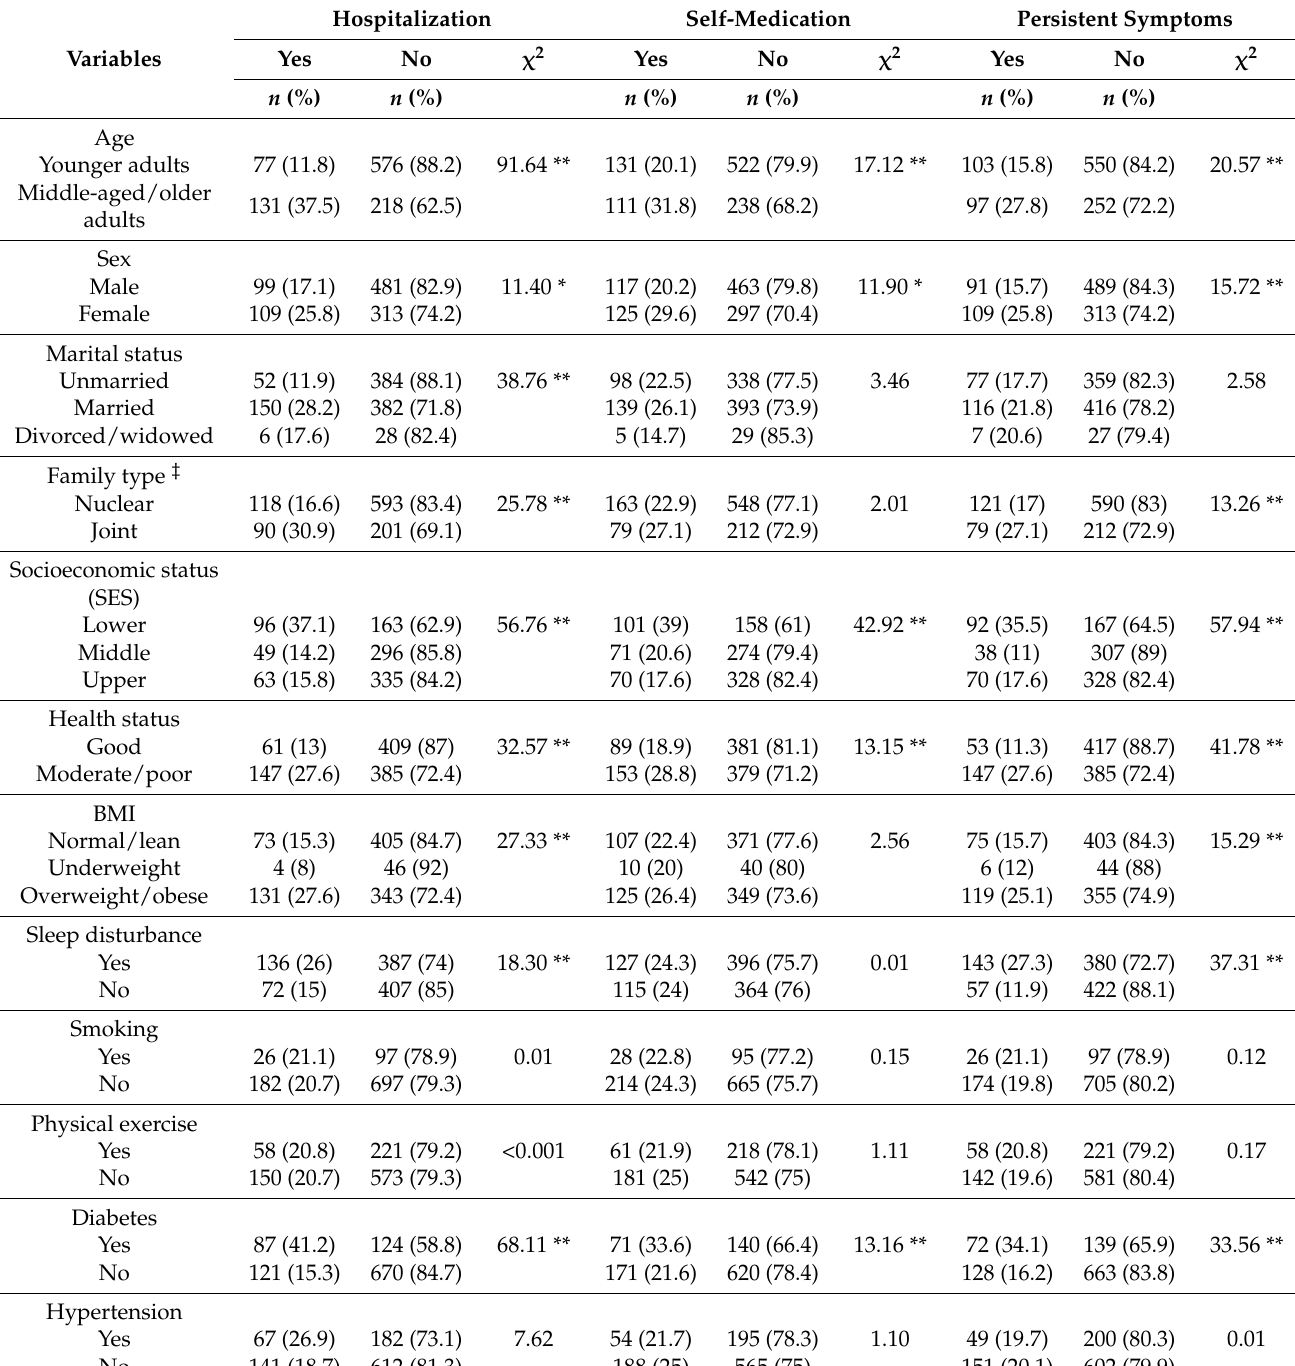
Table 2. Bivariate analyses using self-medication, persistent symptoms, and hospitalization as dependent variables. Hospitalization Self-Medication Persistent Variables